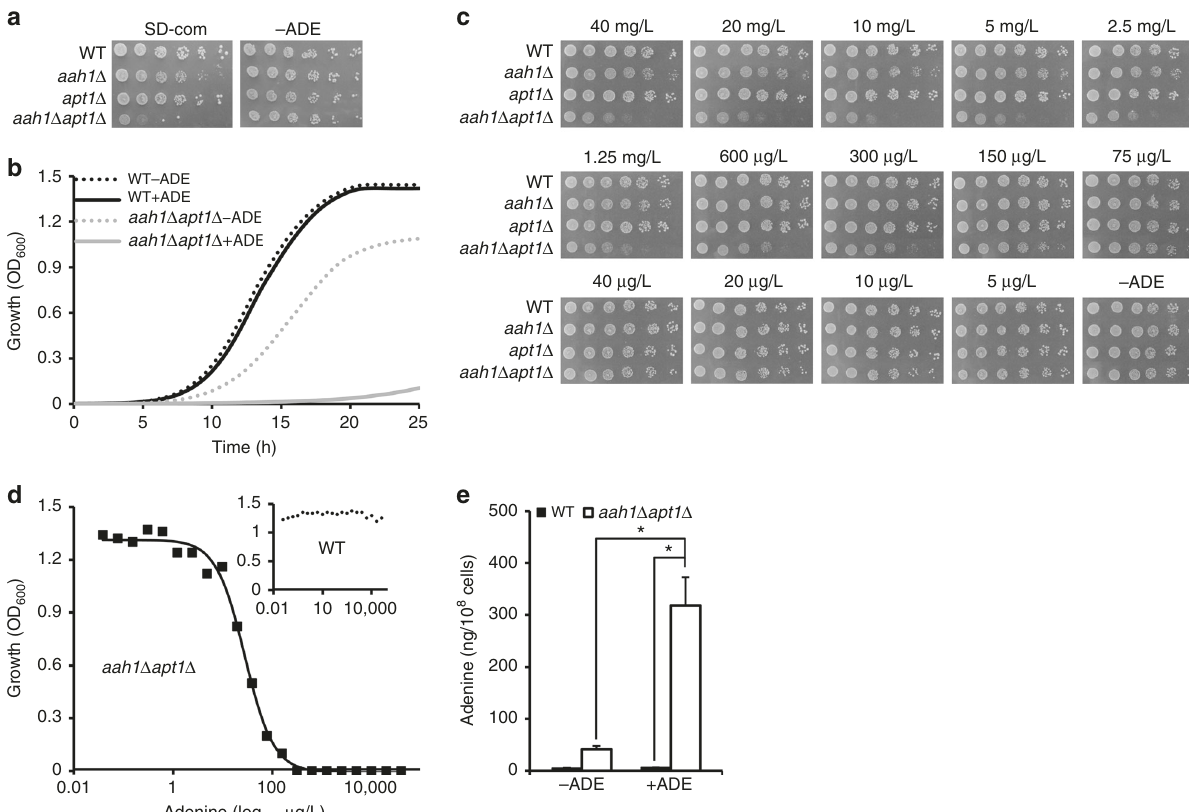
Fig. 1 Sensitivity of the salvage mutant to adenine feeding. a Wild-type (WT), aah1 Δ , apt1 Δ , and aah1 Δ apt1 Δ strains were serially diluted and spotted on SD complete medium containing 20 mg/L adenine (SD-com) or on SD medium without adenine ( − ADE). b Growth curves of WT and aah1 Δ apt1 Δ cells in SD media with or without adenine (ADE). SD-com is denoted as + ADE to emphasize the presence of adenine in the standard yeast growth medium. c WT, aah1 Δ , apt1 Δ , and aah1 Δ apt1 Δ strains were serially diluted and spotted on SD medium with various concentrations of adenine, ranging from 40 mg/L (~300 µ M) to 5 µ g/L (~0.0375 µ M), or without adenine ( − ADE). d Cells were grown in the presence of different concentrations of adenine, ranging from 40,000 µ g/L (~300 µ M) to 0.038 µ g/L (~0.029nM), in SD medium and the absorbance at 600 nm was measured at the logarithmic phase. The results were fi tted using a four-parameter logistic equation (4PL), R 2 > 0.99. Inset shows the absorbance of the WT at 600 nm. e Intracellular concentration of adenine determined using GC – MS. WT and aah1 Δ apt1 Δ cells were grown in SD media in the absence ( − ADE) or presence ( + ADE) of adenine and the metabolites were extracted. * P < 0.01 (Student ’ s t -test). Values are the mean ± s.d. of three